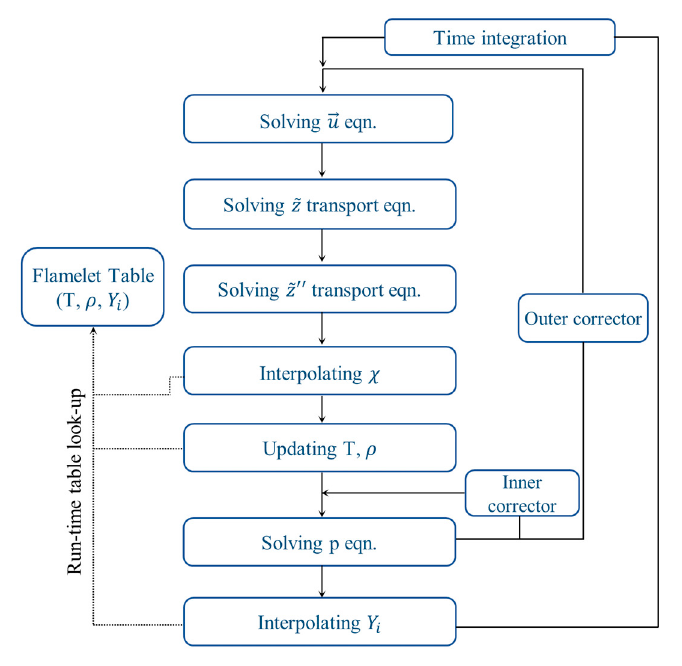
Figure 4. Process flow of the SLFMFoam_LES solver algorithm.